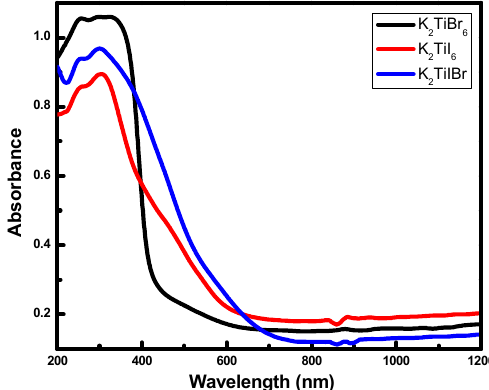
Figure 3. Absorption curve for K 2 TiI 6 , K 2 TiBr 6 and K 2 TiI 2 Br 4 .